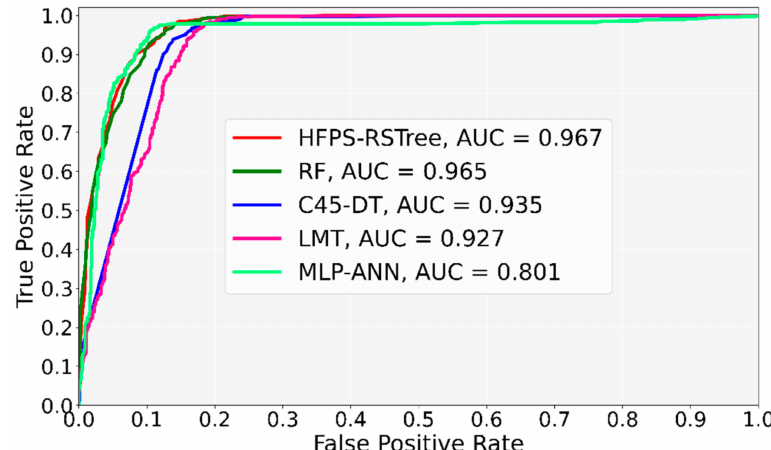
Figure 4. The AUC for the flash flood models using the validation dataset.